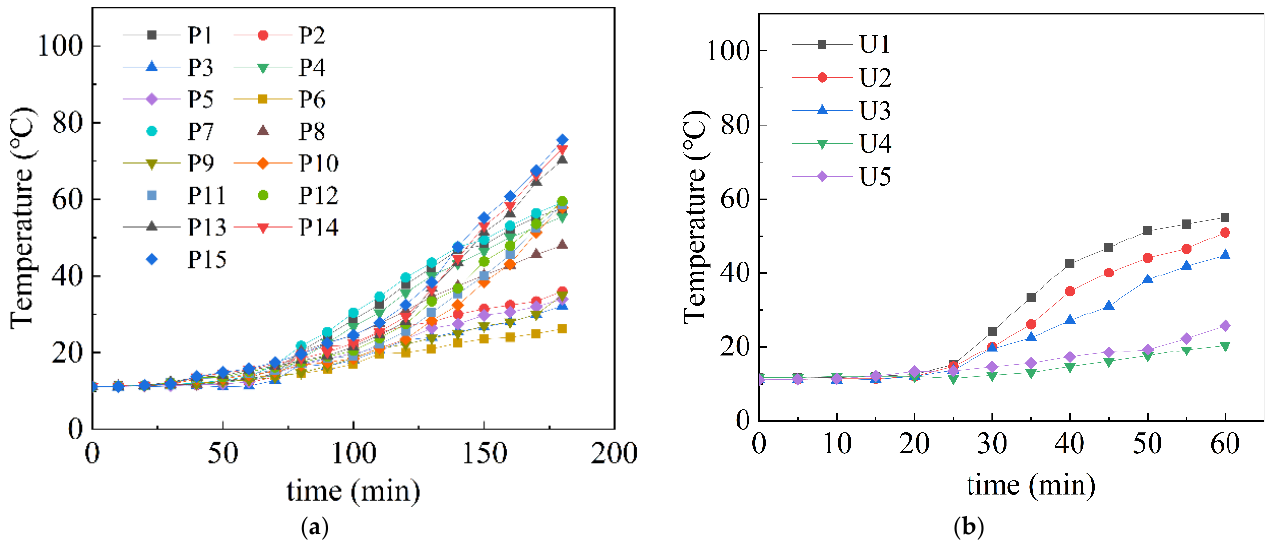
Figure 14. T-t curves at the measurement points of test N: ( a ) test N(1); ( b ) test N(2). In test N(2), the temperature shows a similar rising trend at U1, U2, and U3 on the wall panel. The temperatures at the points of the H-shaped steel column showed a